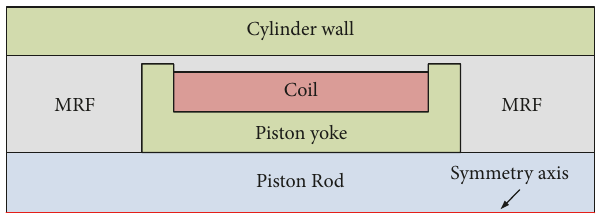
Figure 9: 2D axisymmetric geometric model of MRF